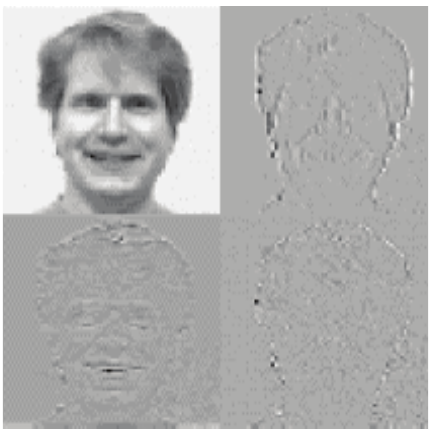
Figure 6: 1-level DWT decomposition.